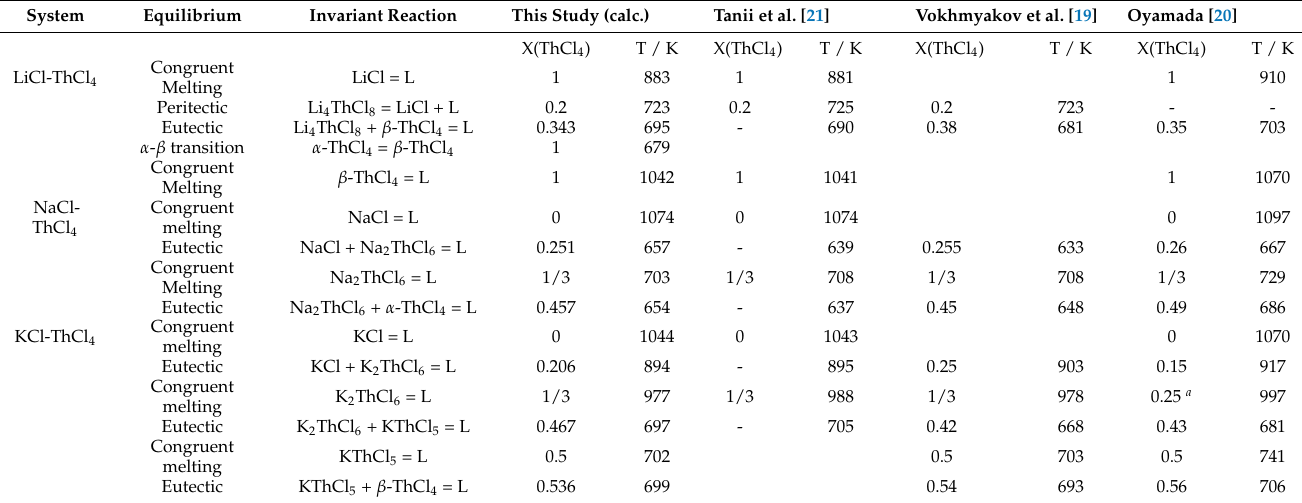
Table 4. Invariant equilibrium data in the ACl-ThCl 4